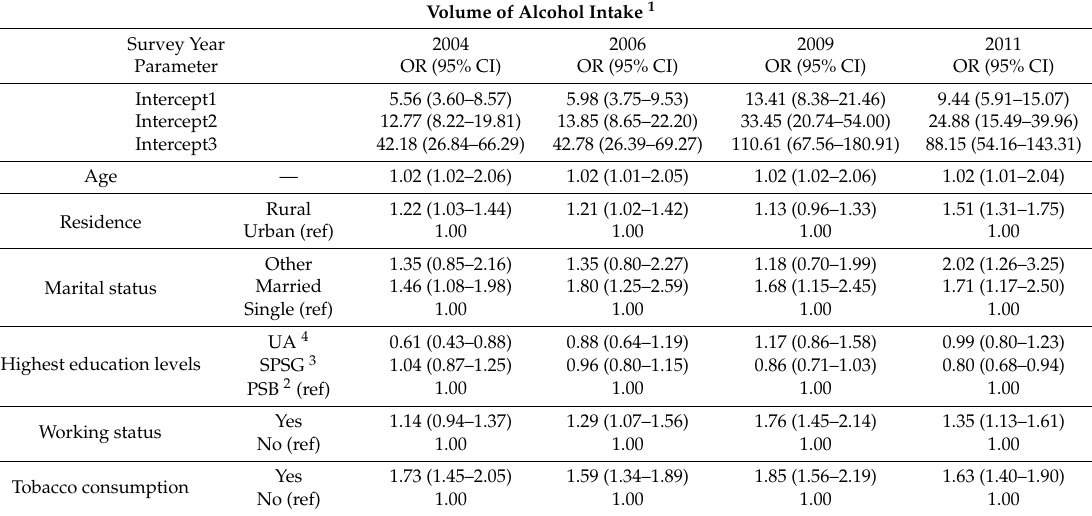
Table 3. Ordered logistic regression model analysis for the volume of alcohol intake amongst Chinese male drinkers, CHNS.